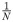
Comparison of patient stratifications obtained with the raw mutation data, NSQN (Pathway Commons) and NetNorM (Pathway Commons) for 8 cancer types.(a) Association of patient subtypes with survival time. One circle indicates P ≤ 0.05 and two concentric circles indicate P ≤ 0.01 (log-rank test). Cases where clusters were too unbalanced (95% of the patients in one single cluster) are not shown. (b) Evaluation of the clustering stability as measured by the proportion of ambiguous clustering (PAC). The transparency of the triangles indicate the percentage of patients in the largest cluster. The scale ranges from 100% (totally opaque) to 1N % (totally transparent) where N is the number of subtypes. Therefore opacity (resp. transparency) indicate unbalanced (resp. balanced) clusters. (c) Kaplan Meir survival curves for NetNorM subtypes with significantly distinct survival outcomes. In the legend are indicated the subtype number followed by the number of patients in the subtype.